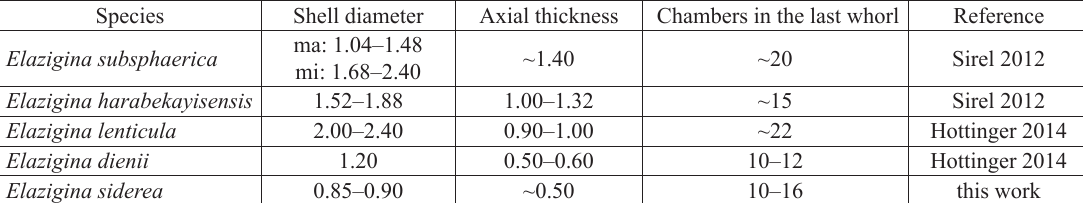
Table 1. Comparison of biometrical measurements (in mm) in the species of Elazigina . Abbraviations: ma, megalospheric form; mi, microspheric